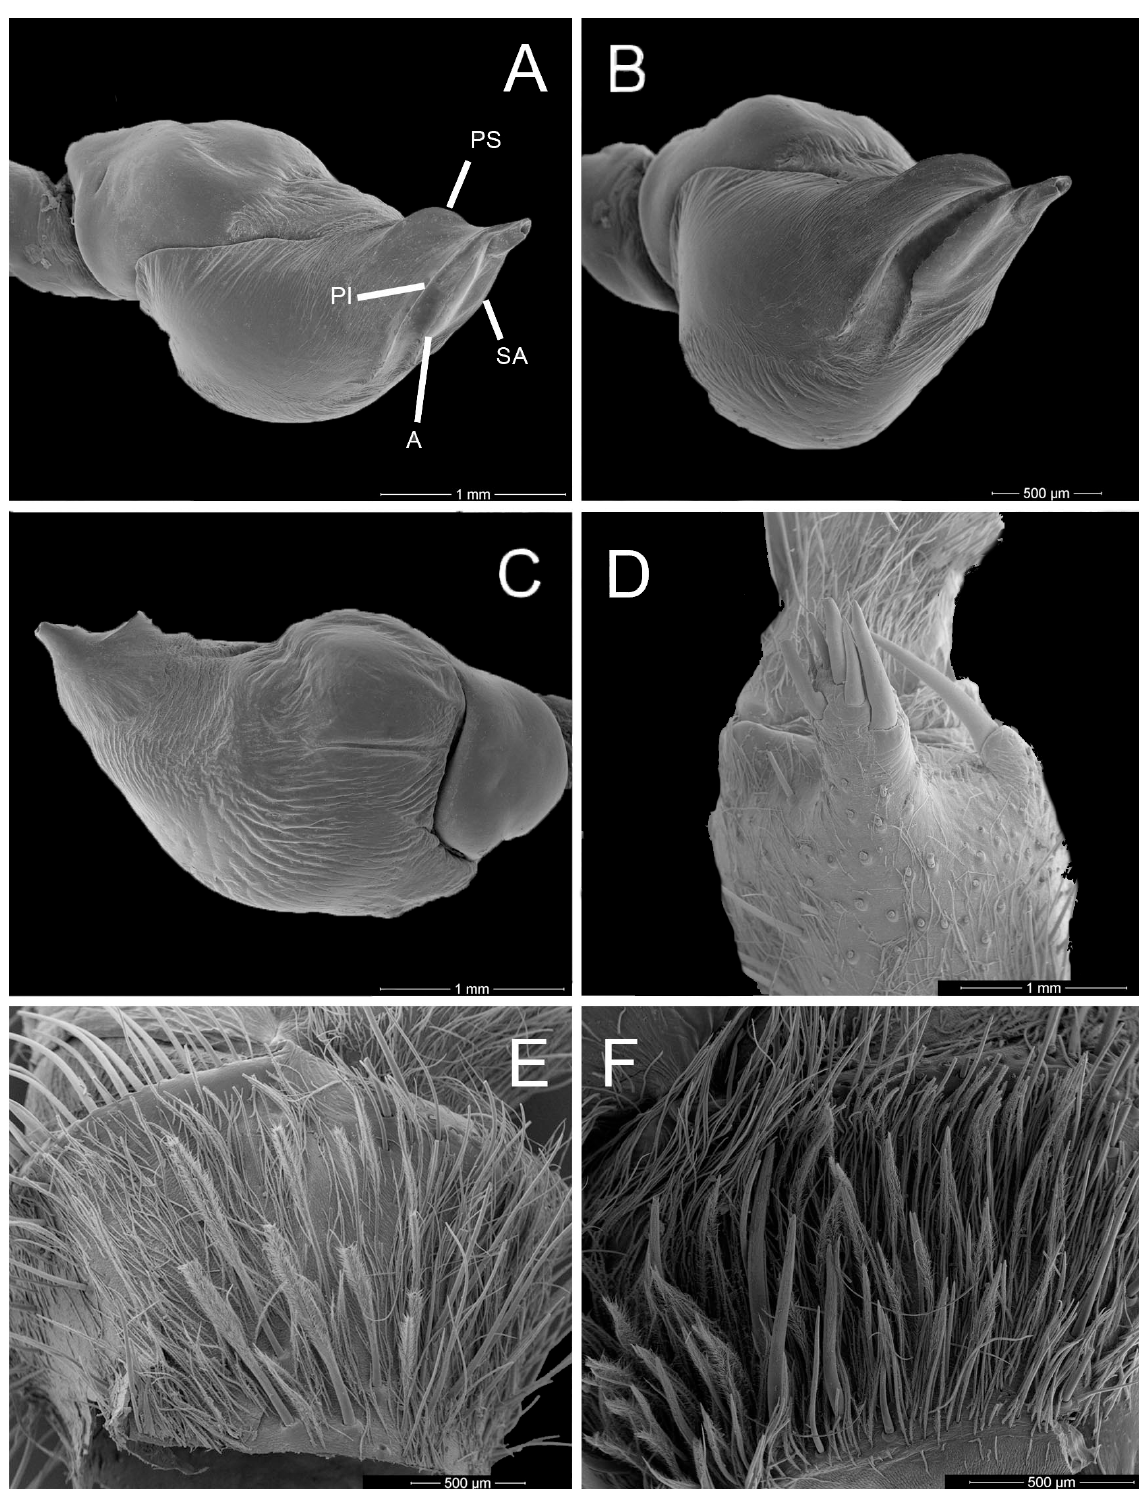
Fig. 26. Umbyquyra tucurui gen. et sp. nov., holotype, ♂, Tucuruí, Pará, Brazil (IBSP 104834). A . Palp, prolateral. B . Anterolateral. C . Retrolateral. D . Tibial apophysis, retrolateral. E . Stridulatory organ, trochanter. F . Trochanter I. Abbreviations: see Material and